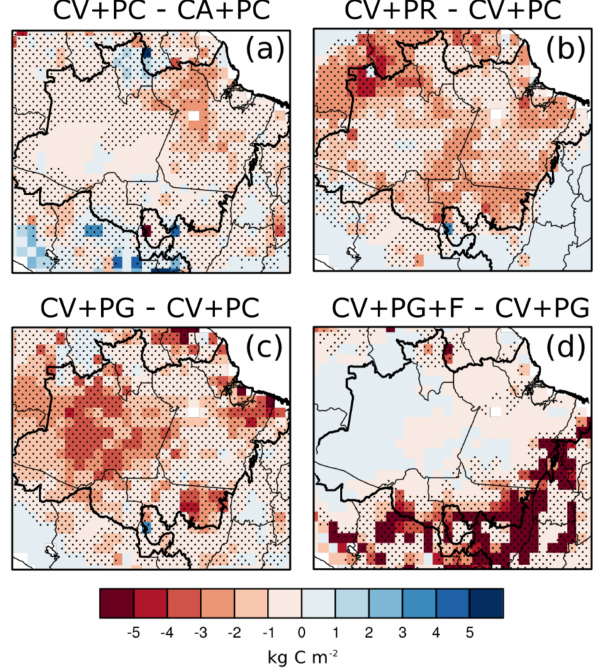
Figure 4. Effects of interannual climate variability (a) , regional P limitation (b) , global P limitation (c) , and fire (d) on tree biomass (TB). The stippled areas indicate that the variables are significantly different compared to the control simulation at the level of 95% ac- cording to the t test. The thick black line indicates the geographical limits of the